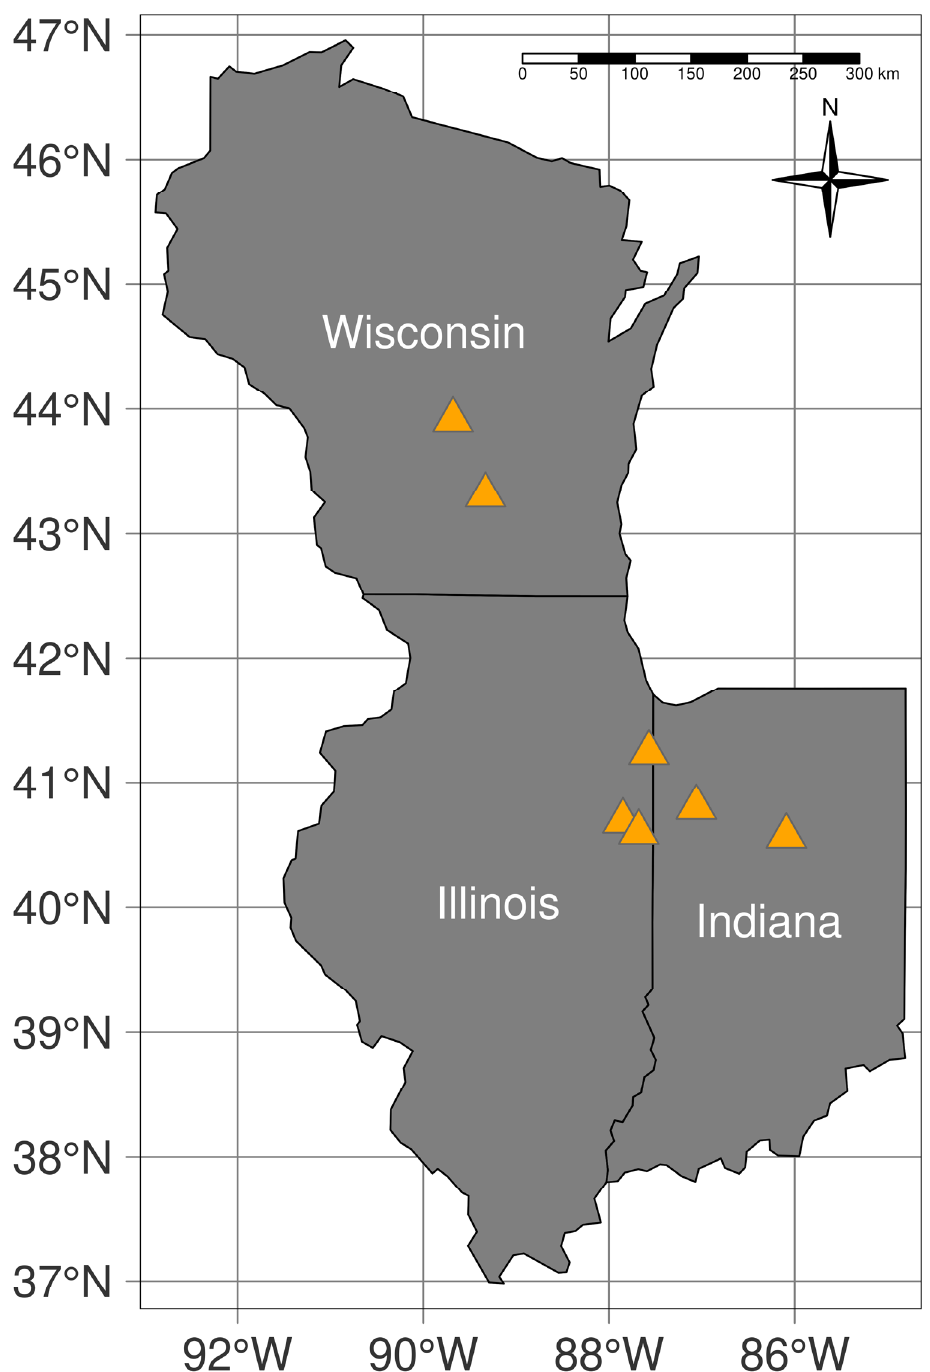
Figure 2. Location of the field sites providing phenology and biomass data used for the calibration of the cereal rye model.